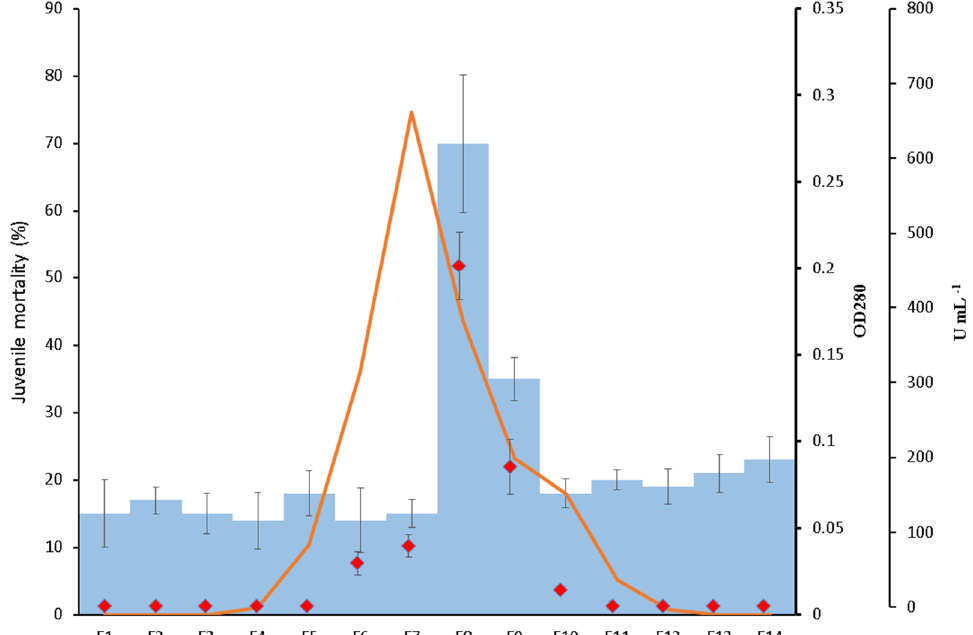
Fig. 2 Anion exchange chromatography of precipitated proteins from medium culture. Proteins and peptides was precipitated from medium culture of strain AzBw1 and precipitates re‑suspended in 20 mM Tris buffer with pH 8.0. This preparation was fractionated over Q‑sepharose column and bonded molecules were eluted by different concentrations of NaCl solution. Bonded molecules were collected in 1 ml fractions. These fractions were analyzed for their protease (diamonds), chitinase and nematicidal activity (bars) by standard methods. The line is optical density of fractions at 280 nm. Bars indicate standard error. This experiment was conducted twice with the same results